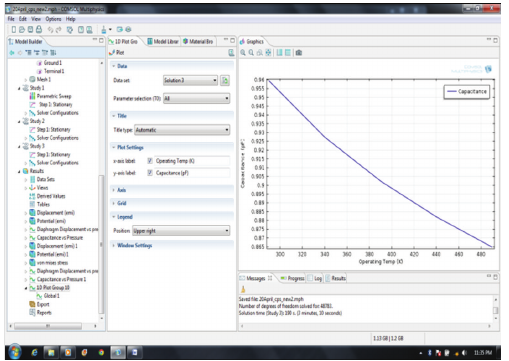
Figure 12: Plot of capacitance versus operating temperature in MEMS capacitive pressure